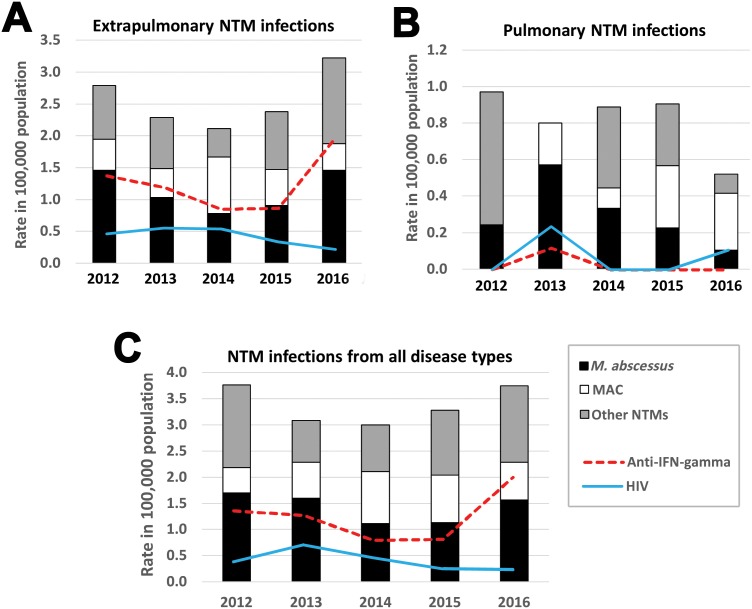
The 5-year trend in NTM infection cases between 2012 and 2016 in Northeast Thailand.The 5-year trend in the prevalence (per 100,000 hospital patient population) of extrapulmonary NTM infection (A), pulmonary NTM infection (B) and all types of NTM infection (C). All true NTM infections (n = 150) are plotted proportional to the number of patients in Srinagarind Hospital in the relevant year. The prevalence of anti-IFN-γ autoantibodies and HIV infection occurring in NTM infected cases are also shown. The total numbers of patients (including outpatients) visiting Srinagarind Hospital in the years 2012–2016 were 823,571, 874,195, 899,747, 883,075 and 960,664 cases, respectively.